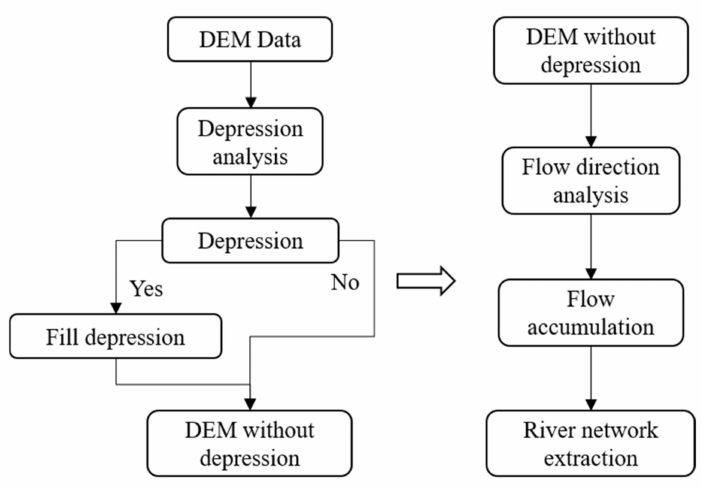
Figure 3. The workflow of river network